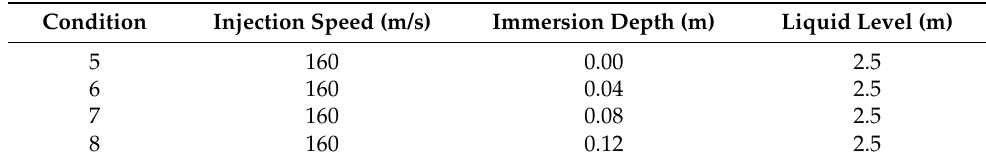
Table 3. Parameters of different immersion depth working condition